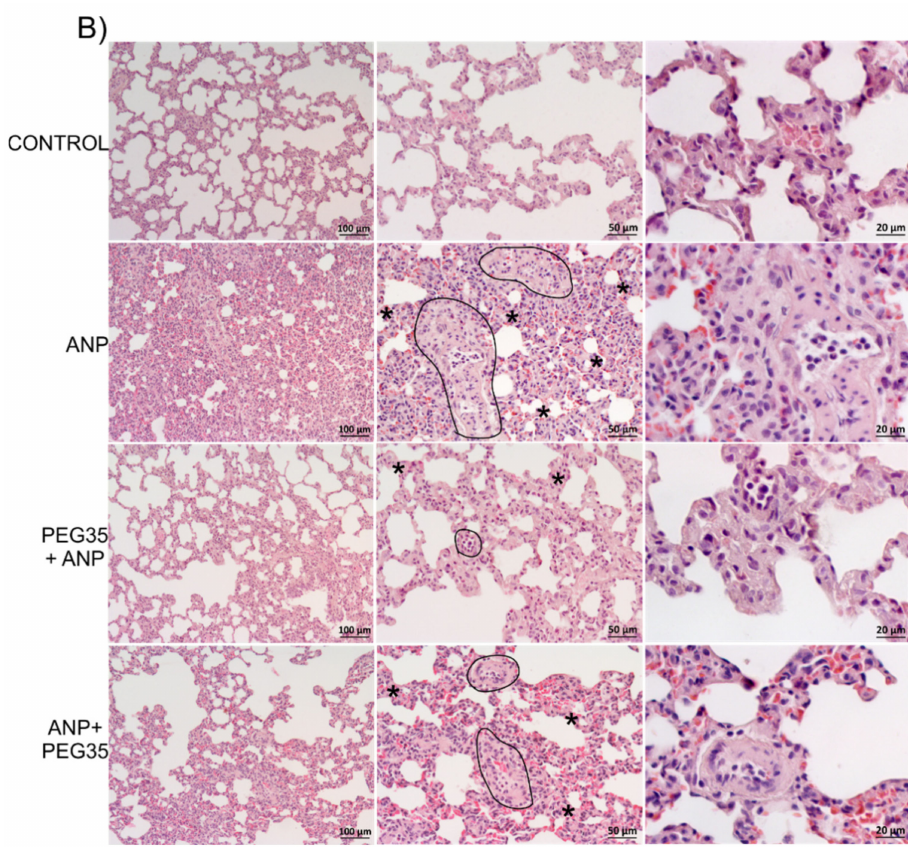
Figure2. E ff ectofPEG35treatmentonhistologicalchangesinexperimentalacutenecrotizingpancreatitis and associated acute lung injury. ( A ) Representative images of hematoxylin and eosin-stained pancreatic sections for each experimental group. Control group showed normal pancreas structure. ANP and ANP + PEG35 groups presented large areas of necrosis (under area), infiltrated polymorphonuclear neutrophils (indicated by empty arrows) and interstitial edema (indicated by an asterisk). Prophylactic administration of PEG35 significantly reduced these features. ( B ) Representative images of hematoxylin and eosin-stained lung sections for each experimental group. Control group showed normal alveolar structure. In the ANP group, a marked alveolar septal thickening (indicated by an asterisk) with infiltrated neutrophils, and the presence of vessel neutrophils (under area) were seen. Both prophylactic and therapeutic PEG35 treatment normalized alveolar septal thickening and neutrophils infiltration. ANP, Acute Necrotizing Pancreatitis. PEG35, Polyethylene glycol 35. Scale bar, 100, 50 and 20 µ M. Table 1. Pancreatic and pulmonary lesions in all experimental groups. Pancreas Lung Alveolar wall Infiltrated Vessel Edema Inflammation Necrosis thickening neutrophils neutrophils